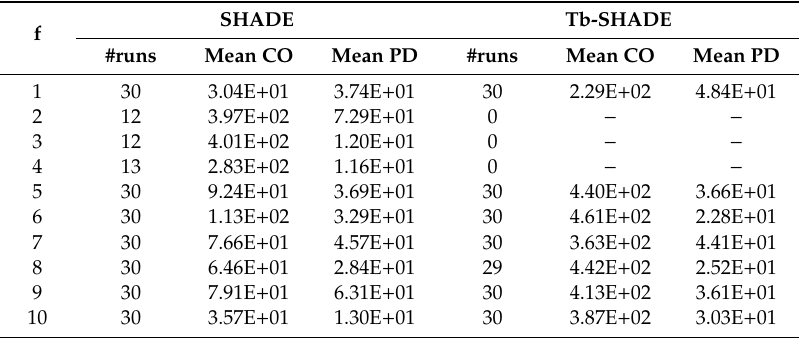
Table 23. Clustering and population diversity of SHADE and Tb-SHADE on the CEC2020 in 5 D .